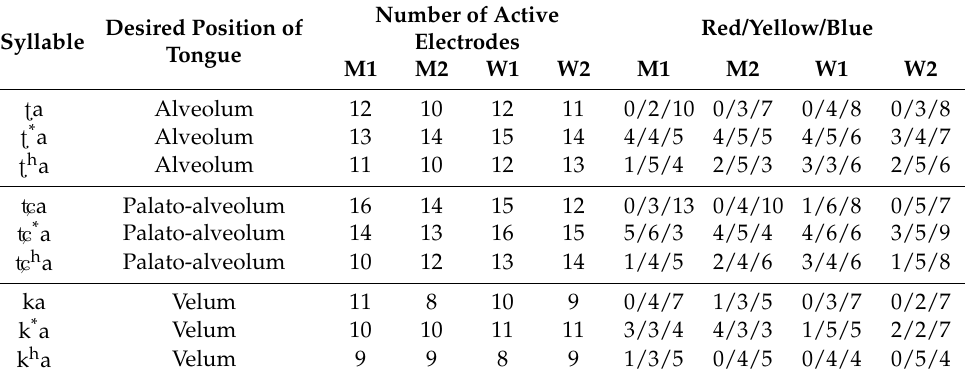
Figure 9. Electropalatography results from the experimental control group: ( a ) male 1, ( b ) male 2, ( c ) female 1, and ( d ) female 2. Table 2. Results of the healthy test group according to the tongue position and intensity of pro- duction.